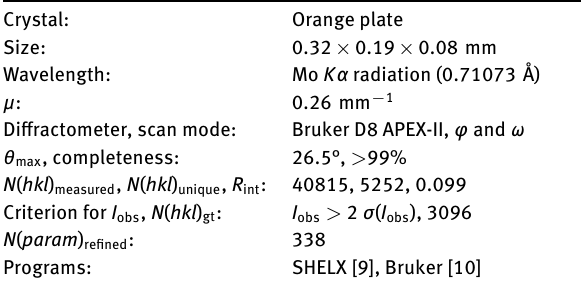
The asymmetric unit of the crystal structure is shown in the figure. Tables 1 and 2 contain details on crystal structure and measurement conditions and a list of the atoms including atomic coordinates and displacement parameters.